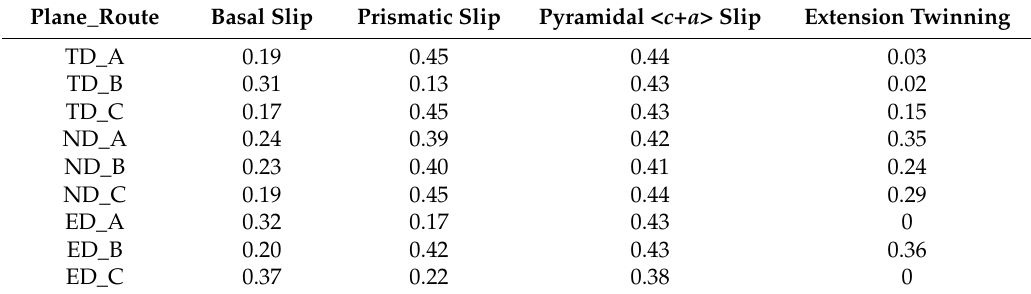
Table 3. Schmid factors for the particular deformation mechanisms in particular billet planes calculated for uniaxial